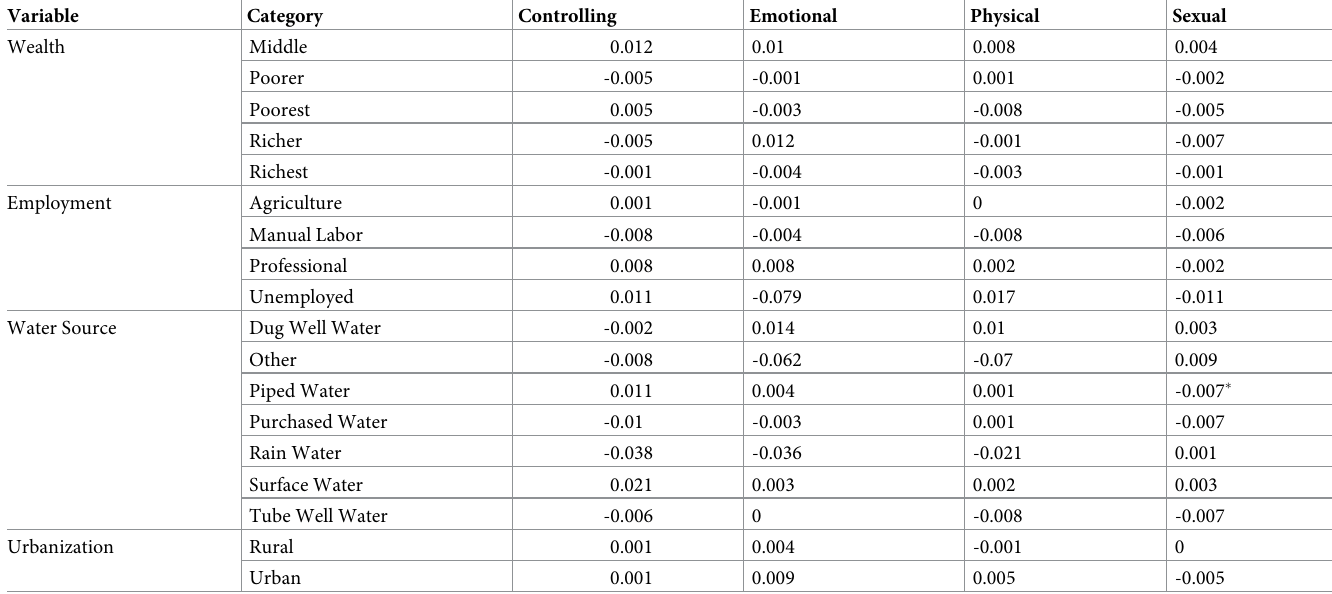
Table 3. Effect of drought on